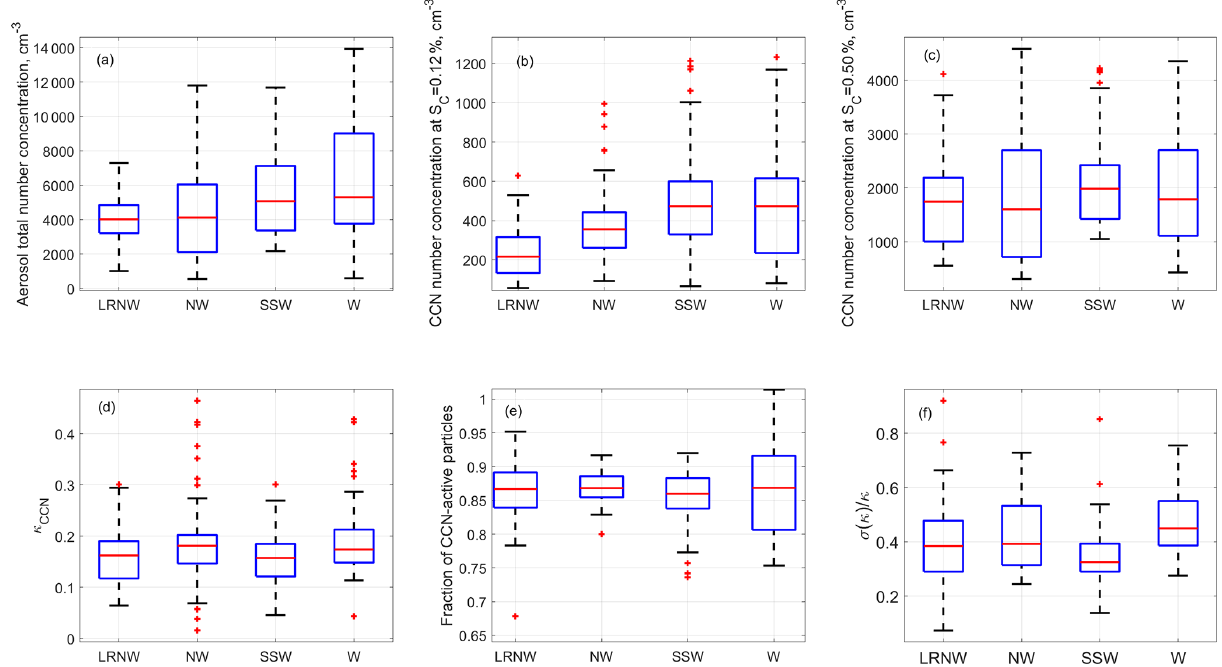
Figure 1. The averaged aerosol properties were observed for each air mass cluster at the BNL site from 15 July to 9 August 2012. (a) Aerosol total number concentration; (b) CCN concentrations measured at supersaturations of 0.12% and (c) 0.50%; the derived properties for the CCN active particles ranging from 80 to 250nm; (d) overall aerosol hygroscopicity; (e) maximum activation fraction; and (f) dispersion of size-selected CCN active particles. The ends of the whiskers represent the minimum and maximum of data except for the outlines (red cross), which are defined as points outside of ± 2 . 7 σ . The bottom and the top of the box are the 25th and 75th percentiles; the line inside the box is the 50th